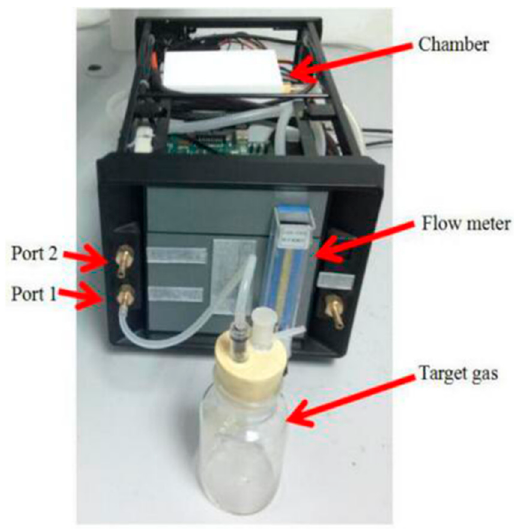
Figure 1. Schematic diagram of the experimental system.